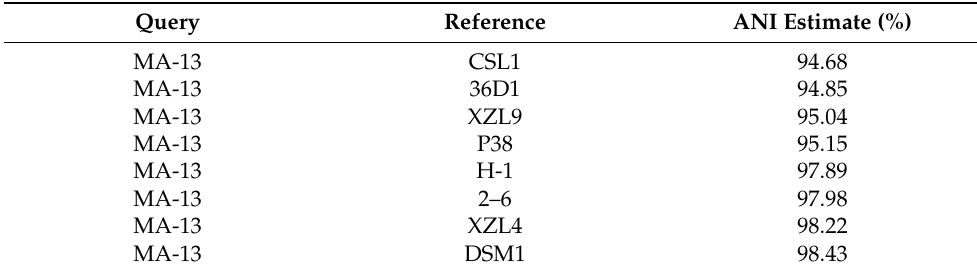
Figure 1. Phylogenetic tree based on the genome comparison of the nine strains of W. coagulans . Table 1. ANI value comparisons between the nine strains